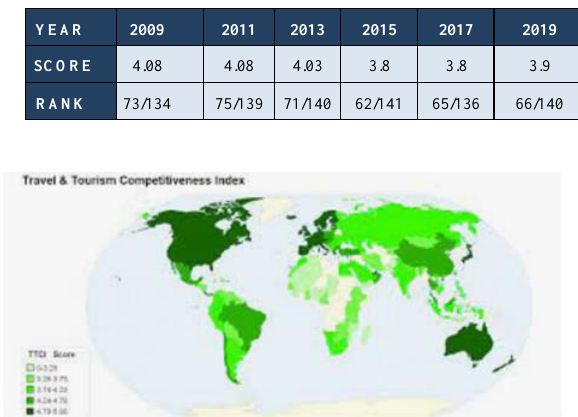
Figure 2: Travel tourism and competitiveness index.